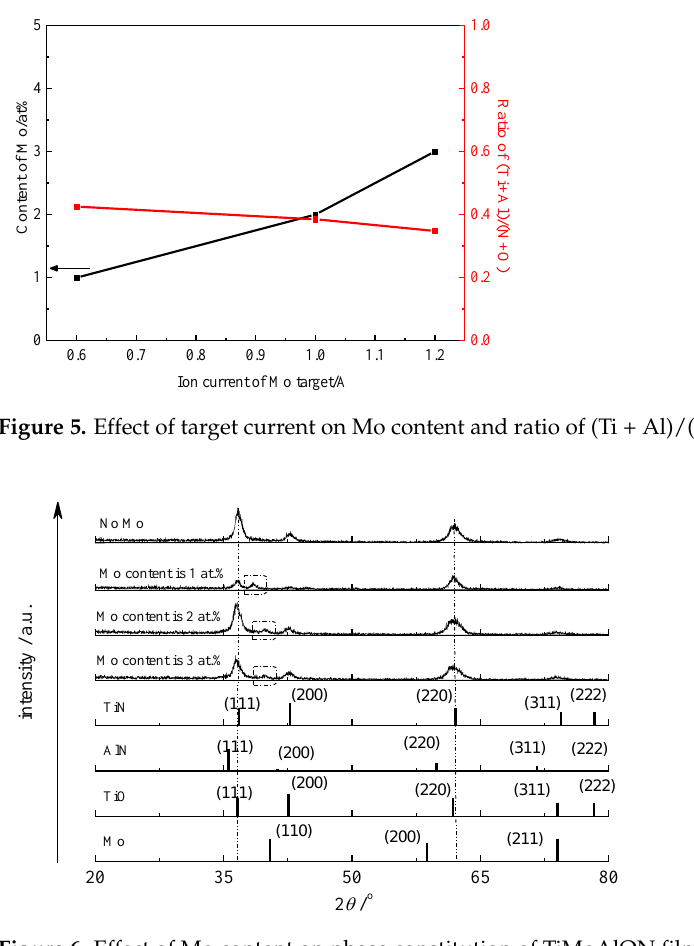
The surface SEM images of Ti/(Mo-TiAlN)/(Mo-TiAlON)/Al 2 O 3 films before and after baking are shown in Figure 7. The film surface is coarse in Figure 7a. After baking at 500 °C in atmosphere for 8 h, unreacted Al is oxidized and the surface Al 2 O 3 layer becomes more pure. The surface layer becomes fine and compact, as seen in Figure 7b.